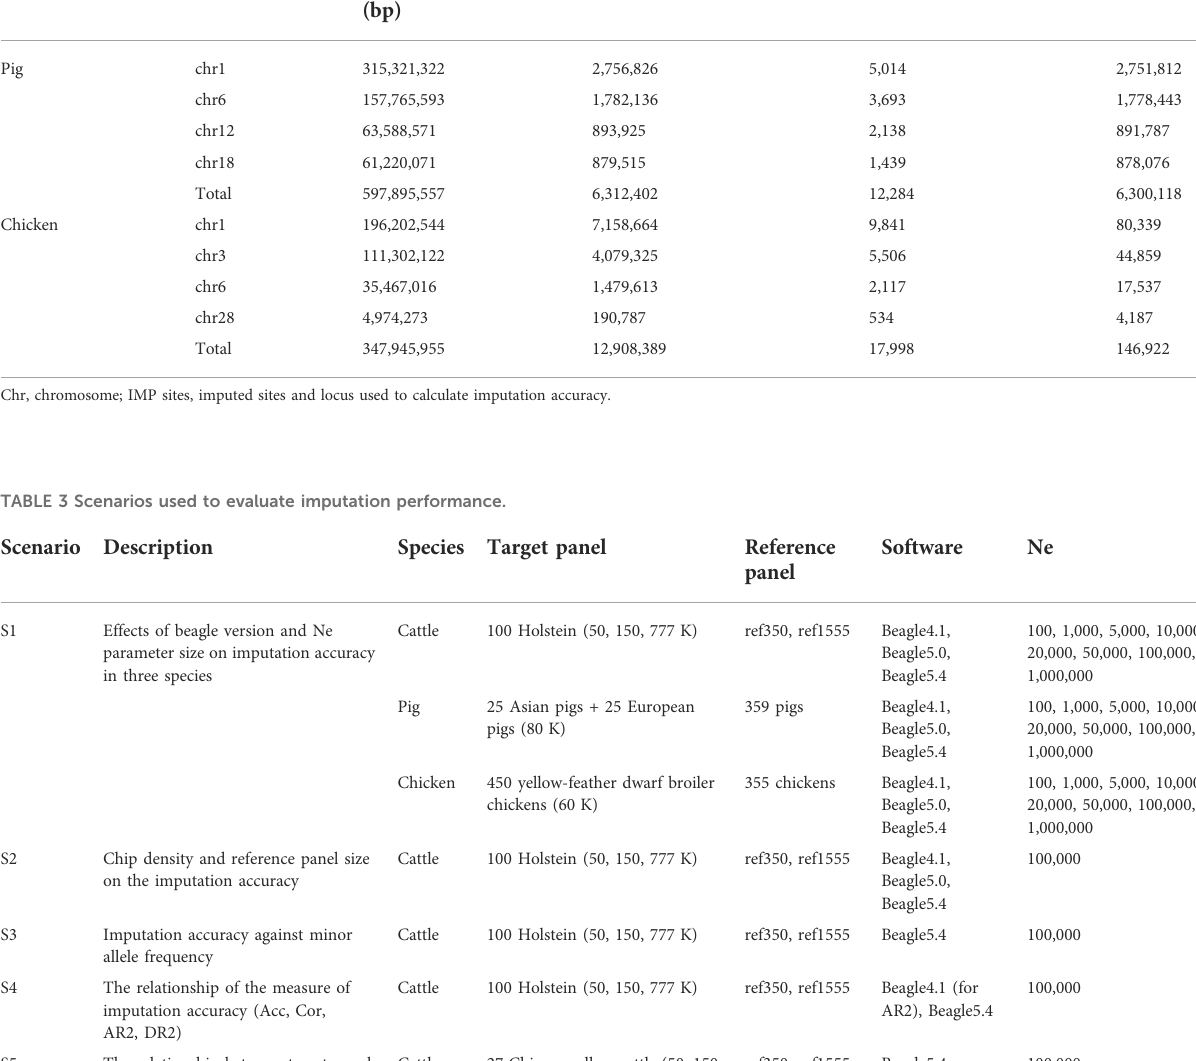
TABLE 2 Number of SNPs used across chromosomes in pigs and chickens.